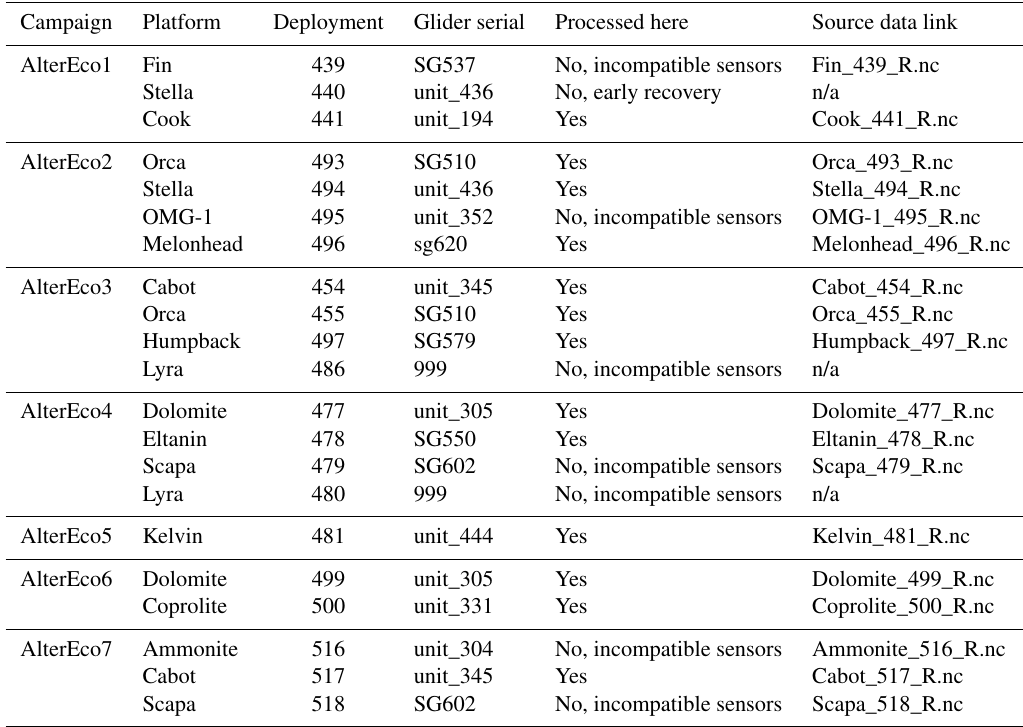
Table 1. An overview of mission nomenclature. All glider data used in the calculation of primary production are available at https:// www.bodc.ac.uk/data/bodc_database/gliders/ and are published at the following URLs: https://www.bodc.ac.uk/data/published_data_library/ catalogue/10.5285/b57d215e-065f-7f81-e053-6c86abc01a82/ and https://www.bodc.ac.uk/data/published_data_library/catalogue/10.5285/